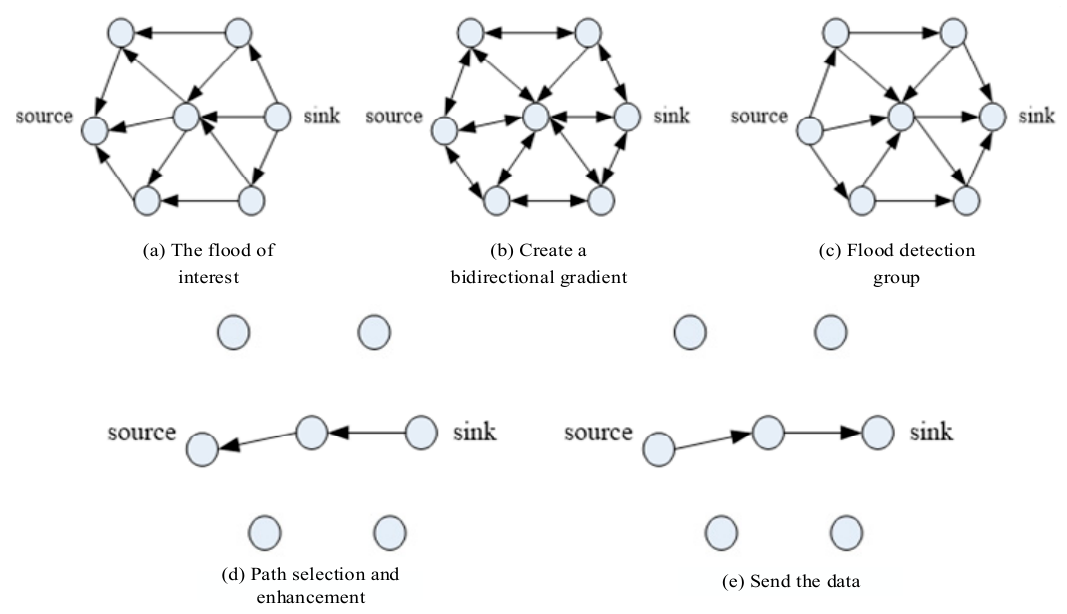
Figure 2. Directional diffusion process.